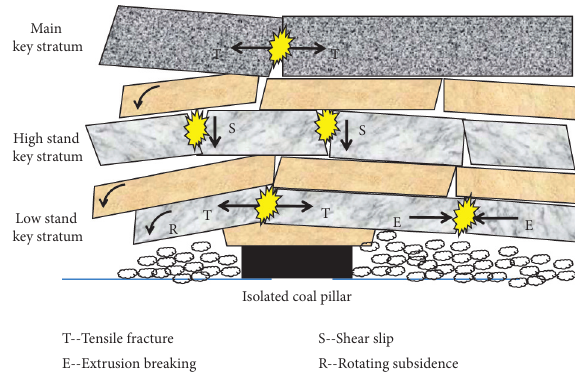
Figure 7: The process of mining earthquake induced by an overburden